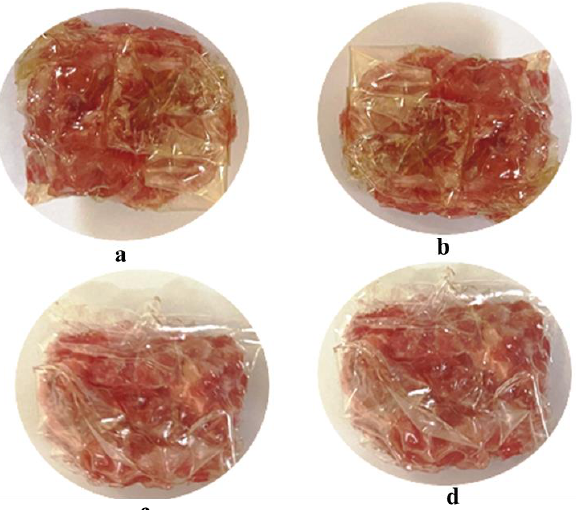
Figure 5. Visual aspects, after 14 days of storage at 4 °C, of minced beef meat packed with ( a ) con- (0%), ( b ) 1-BPE (0.25%), ( c ) 2-BPE (0.5%), and ( d ) 4-BPE (1%) films. trol (0%), ( b ) 1-BPE (0.25%), ( c ) 2-BPE (0.5%), and ( d ) 4-BPE (1%) films.